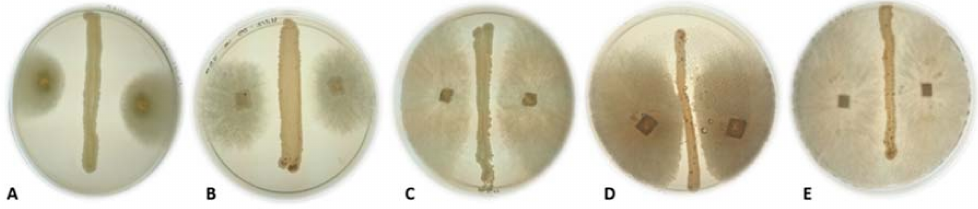
Figure 1. Patterns of antagonistic interaction between yeasts and phytopathogenic fungi grown on potato-dextose agar. ( A ) P. anomala 457 vs. E. lata 16012 (+++); ( B ) Z. bailii 550 vs. E. lata 1190 (++); ( C ) C. sake H1/3-29 vs. B. cinerea 16-14 (+); ( D ) C. sake H1/3-29 vs. B. cinerea 877 ( ± ); ( E ) P. methanolica H1/3-1 vs. R. subterranea CBS 339.96 ( − ). The fungus is strongly inhibited (+++) when growing